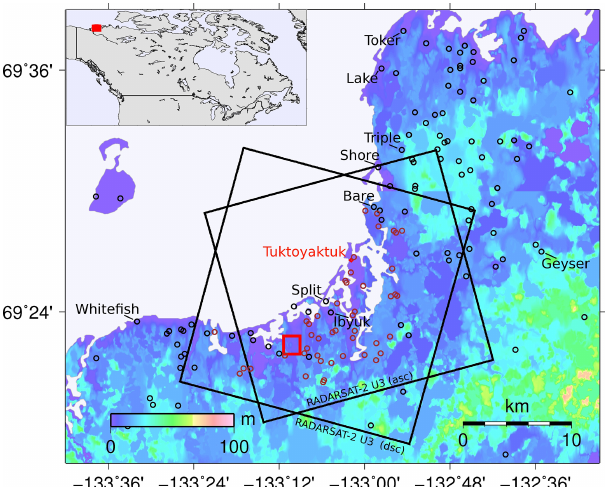
Figure 2. Study site located in Northwest Territories, Canada, is outlined in red. Background is a 90m resolution digital elevation model (GeoGratis Web Services, Natural Resources Canada). As- cending and descending RADARSAT-2 Ultra-fine 3 (U3) frames are outlined in black. Black circles show locations of pingos identified on Canada Base Map (GeoGratis Web Services, Natural Resources Canada). Brown circles show locations of suspected pingos visually identified in high-resolution optical imagery. Names of known pin- gos are shown in black. Extent in top-left corner shows location of site in North